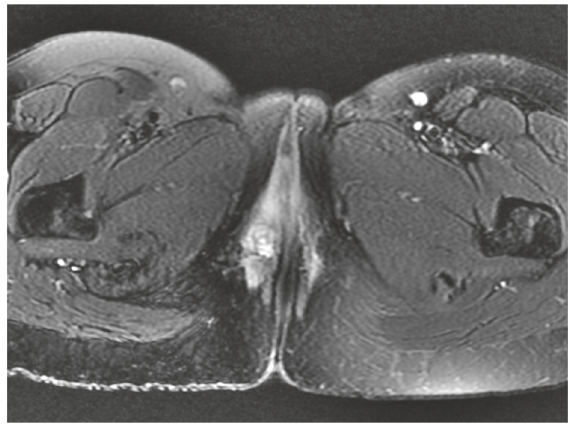
Figure 1: Preoperative T2 axial MRI though the pelvis demonstrat- ing ACCBG lesion in the right vulva.